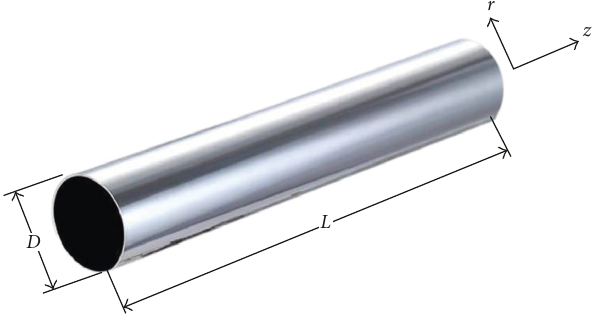
Figure 1: Schematic of a nanofluid pipe flow. Table 1: Thermophysical properties of materials. Thermophysical properties